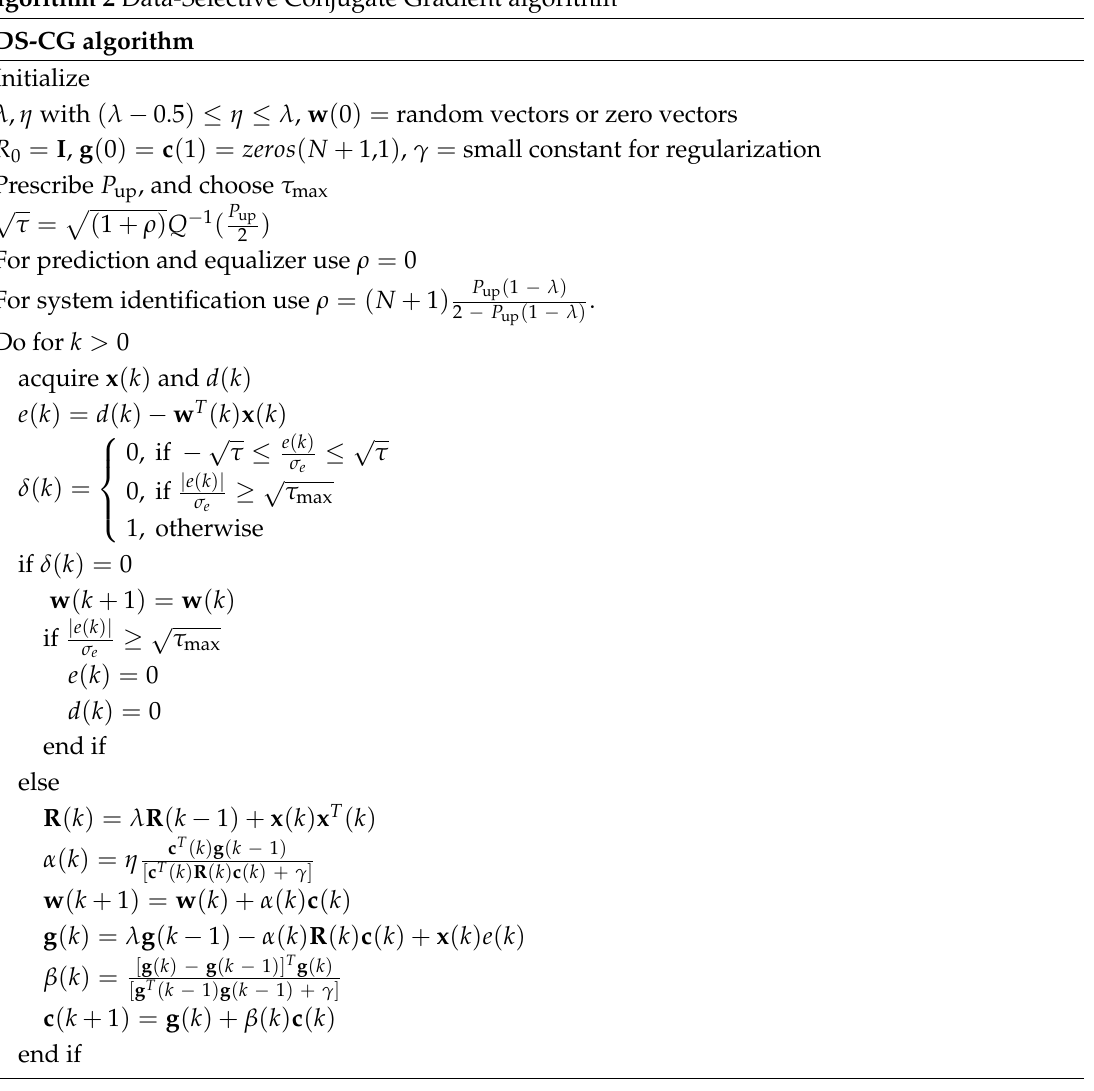
Algorithm 2 Data-Selective Conjugate Gradient algorithm DS-CG